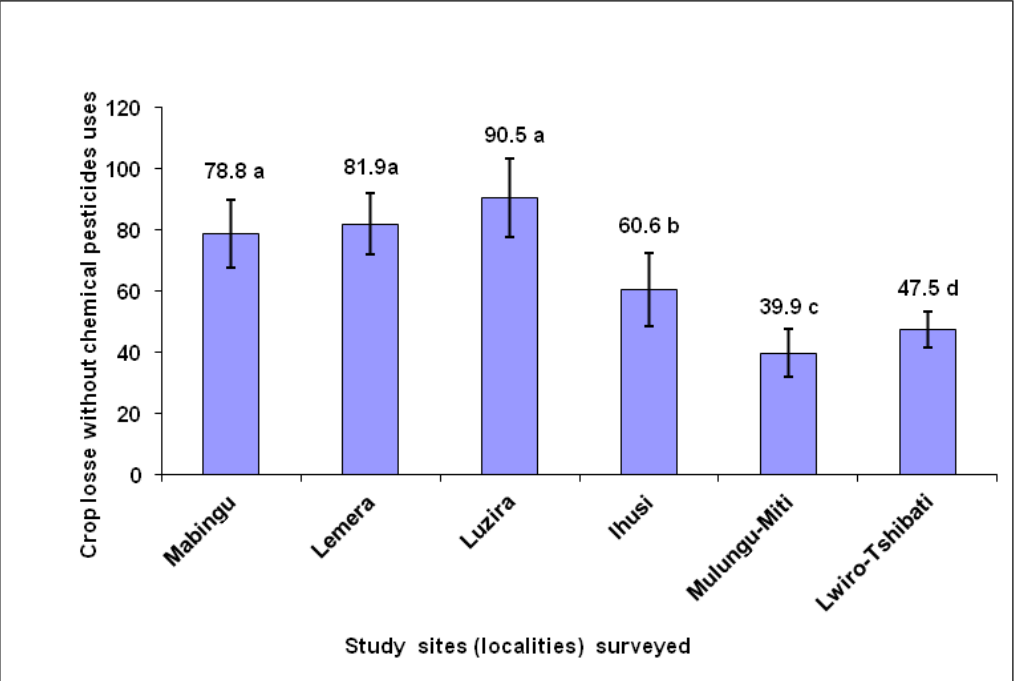
Figure 1: Perceived average potato yield loss due to pests and diseases as reported by farmers interviewed in six irish potato-growing zones, if pesticides are not applied (2016 survey), South-Kivu Province, eastern